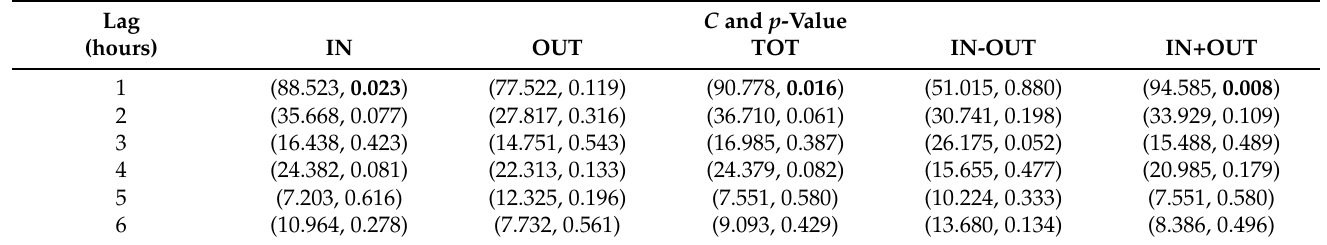
Table 5. Chi-square statistics and p -values of exact traffic counts for different lags for hive H17; 3